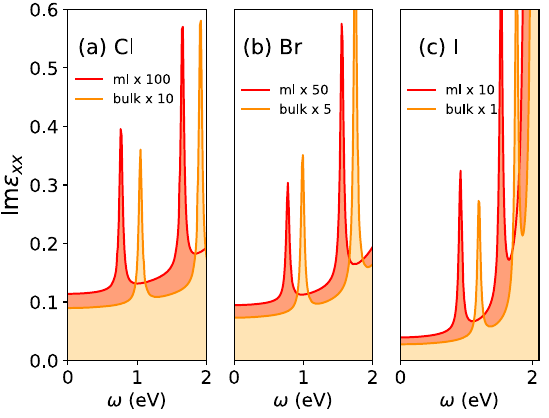
Fig. 3 Benchmarking against experimental optical absorption in bulk CrCl 3 , CrBr 3 . Comparison between the adopted optical absorbance data from the recent experimental work on CrCl 3 − x Br x 42 against our theoretical results. The theoretical spectra for Im ϵ rigidly blue-shifted by ~0.5 eV as our exciton peaks from v 24 c 14 were too deep compared to experiments. Note that the need for such manual blue-shifting would not emerge required if we used the dielectric response computed from a smaller two-particle Hamiltonian, say v 12 c 14 (see Supplemental experimental fi ndings. The position of these excitons change and they become systematically red-shifted as more screening channels are included in the two-particle Hamiltonian we solve using QS G b W . As we show in the Supplemental Material, the two peaks already form when the two-particle Hamiltonian contains the minimal six valence bands ( v ) and four conduction bands ( c ), which are mostly of Cr- dt 2 g ↑ character and Cr- de g ↑ character.